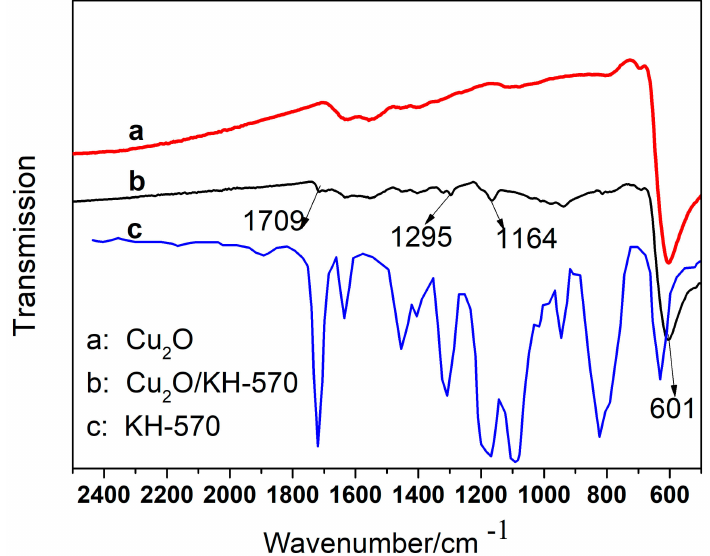
Figure 3. Fourier transform infrared spectroscopy (FTIR) spectra of ( a ) 0-Cu 2 O, ( b ) M-Cu 2 O, ( c )